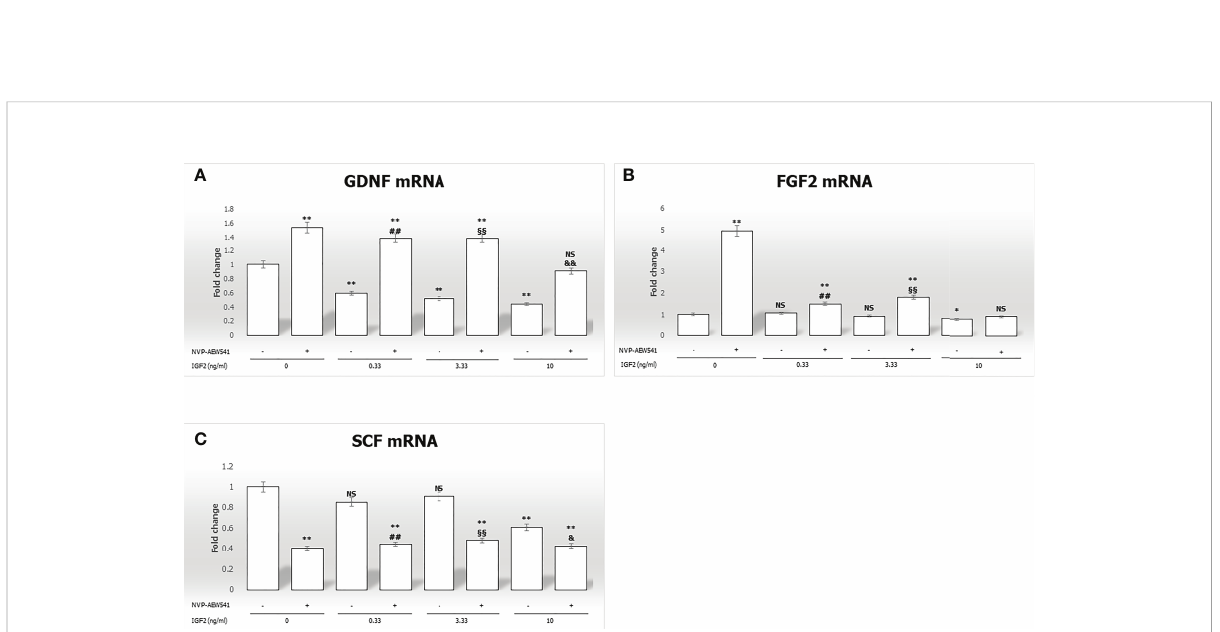
FIGURE 3 Gene expression of the mitogens Glial cell-line derived neurotrophic factor (GDNF) , Fibroblast growth factor 2 (FGF2) , and Stem cell factor (SCF) in Sertoli cells (SCs). RT-PCR analysis of (A) GDNF , (B) FGF2 , and (C) SCF . Data represent the mean ± SD of three independent experiments, each performed in triplicate. SCs were used as a positive control. Non-signi fi cant (NS) vs SCs, *p < 0.05 and **p < 0.001 vs SCs, ##p < 0.001 vs 0.33 ng/ml of rhIGF2, §§p < 0.001 vs 3.33 ng/ml, &p < 0.05 and &&p < 0.001 vs 10 ng/ml of rhIGF2, ns vs 10 ng/ml of